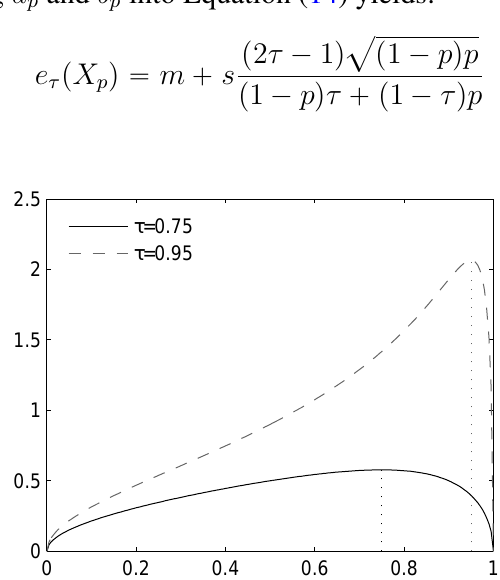
p X q for a diatomic rv X τ p